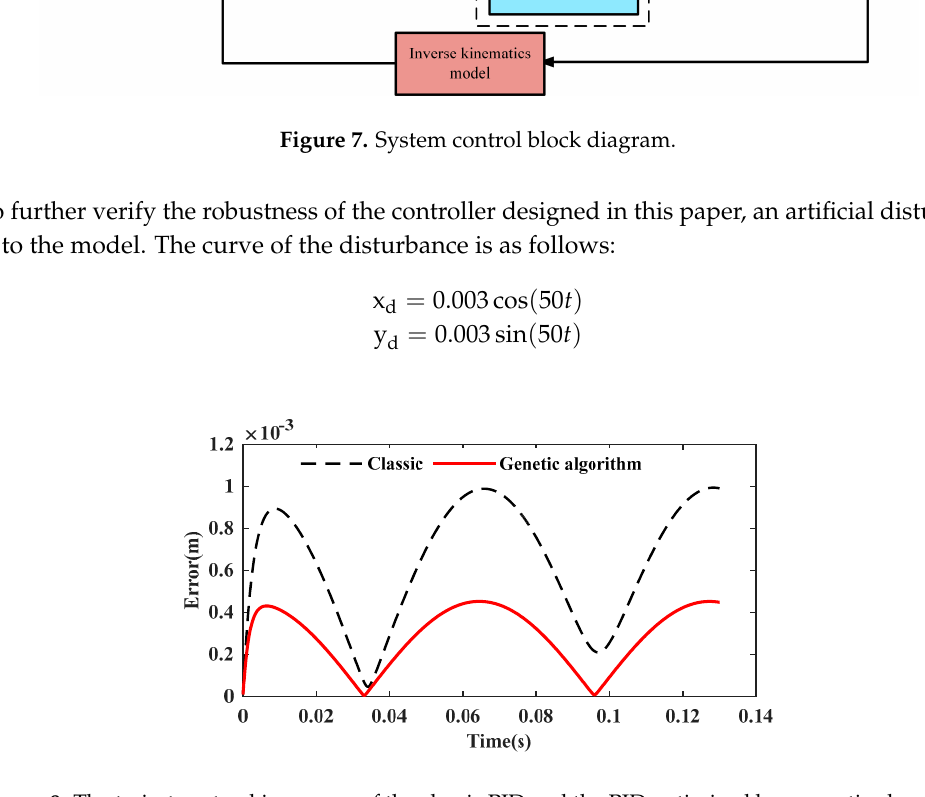
Figure 8. The trajectory tracking errors of the classic PID and the PID optimized by a genetic algorithm.